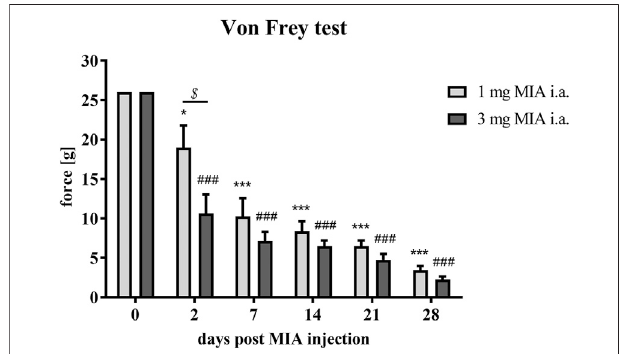
FIGURE 1 | Mechanical allodynia measured by quantifying tactile sensitivity during OA developme with MIA grading. Pain sensitivity was measured with von Frey fi laments in the ipsilateral paw (rear right) prior to MIA injection and 2, 7, 14, 21, and 28 days post-MIA treatment (1 or 3 mg intra-articular injection; i. a.; n (cid:2) 8 animals per group). Two-way ANOVA and Tukey ’ sHSDpost-hoctestingwasperformed.*denotes p < 0.05;***denotes p < 0.001 in each day vs. day 0 in the 1 mg group; ### denotes p < 0.001 in each day vs. day 0 in the 3 mg group, $ denotes p < 0.05 1 mg vs. the 3 mg